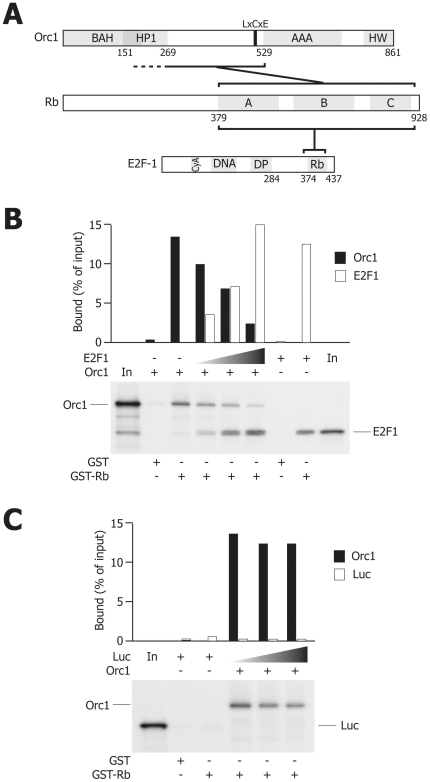
E2F1 competes with Orc1 for binding to Rb.(A) Schematic representation of the regions involved in the association of Rb to Orc1 and of those that are necessary for stable association with E2F1. (B) GST pull-down experiment performed by incubating a fixed amount of in vitro translated Orc1 together with scalar amounts of in vitro translated E2F1 with an immobilized GST fusion protein containing the ABC pocket of Rb. The graph shows the quantification of bound E2F1 and Orc1 radioactivity; the input lanes (In) contain the labelled proteins prior to binding. (C) Competitive GST pull-down control experiment performed with in vitro translated Orc1 and luciferase (Luc) proteins using identical experimental conditions as in (B).